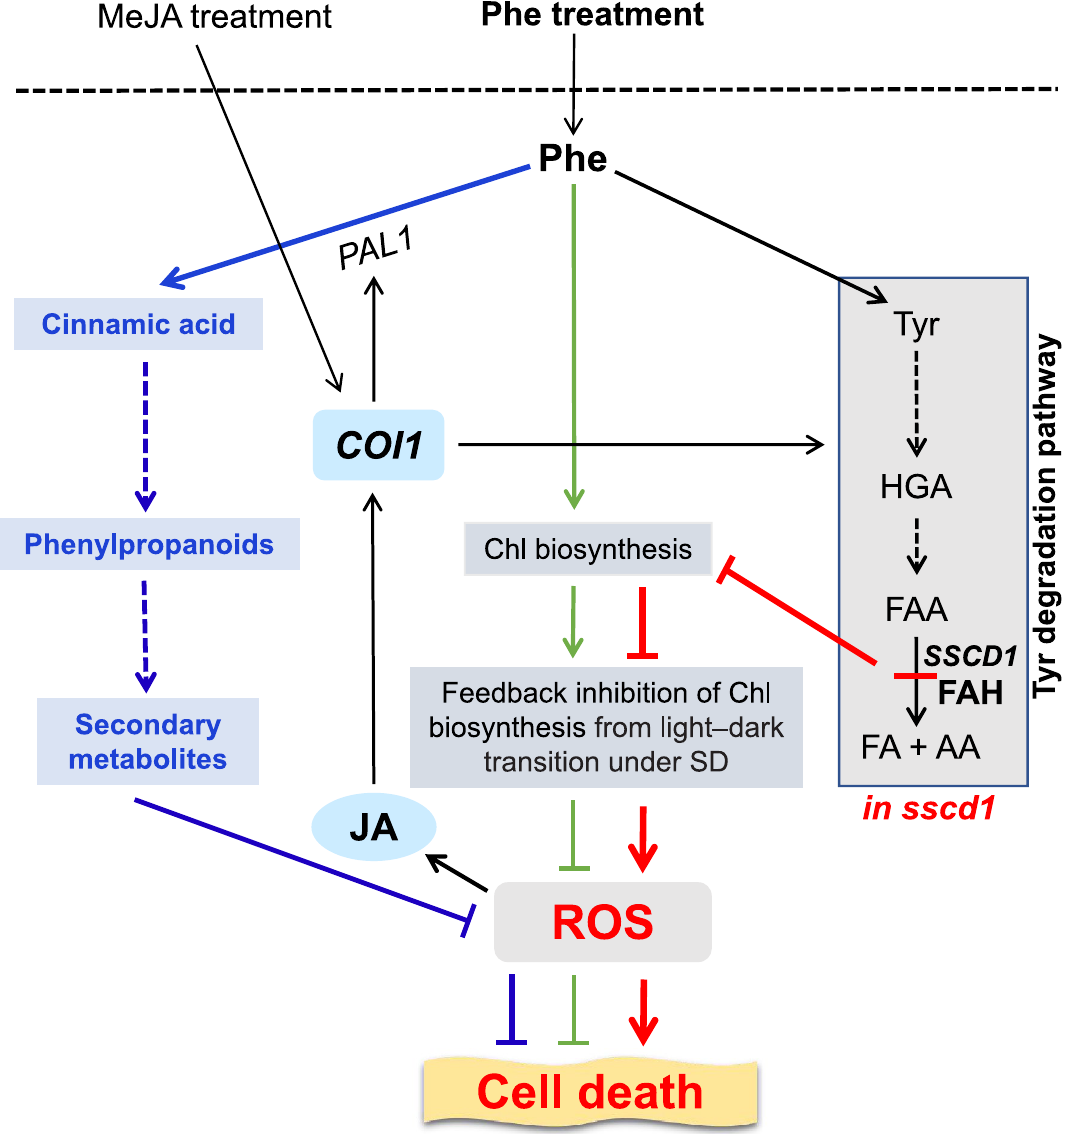
Figure 8. The possible mechanisms by which Phe treatment represses the sscd1 cell death. The SSCD1 gene encodes FAH catalyzing the last step of Tyr degradation pathway. Disruption of FAH in sscd1 reduces Chl biosynthesis, which impairs the feedback inhibition of Chl biosynthesis from light–dark transition under SD, leading to the accumulation of ROS and then cell death (red lines and arrows). Phe treatment promotes Chl biosynthesis, which increases the feedback inhibition of Chl biosynthesis from light–dark transition under SD, reducing ROS and subsequent cell death (green arrows and lines). Meanwhile, Phe treatment activates phenylpropanoid pathway, which reduces ROS and subsequent cell death (blue arrows and lines). In the sscd1 mutant, ROS induces cell death and the JA production. JA up-regulates Tyr degradation pathway through COI1 , promoting cell death, however, it also up-regulates PAL1 through COI1 , which activates phenylpropanoid pathway, repressing cell death. The effect of MeJA treatment on sscd1 cell death through phenylpropanoid pathway might be greater than that through Tyr degradation pathway, resulting in that MeJA treatment enhances the repression of sscd1 cell death by Phe. Arrows indicate induction or positive regulation, whereas lines indicate repression or negative regulation. Arrows with dashed lines indicate multiple steps. FAH fumarylacetoacetate hydrolase; Chl chlorophyll; SD short day; ROS reactive oxygen species; Phe